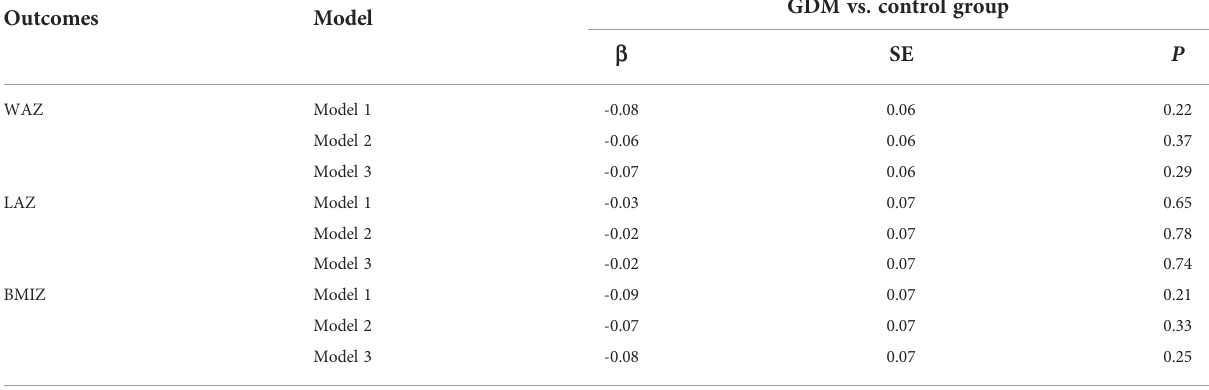
TABLE 2 The general linear model ’ s parameter outcome comparison of Z scores at birth in both groups. Outcomes